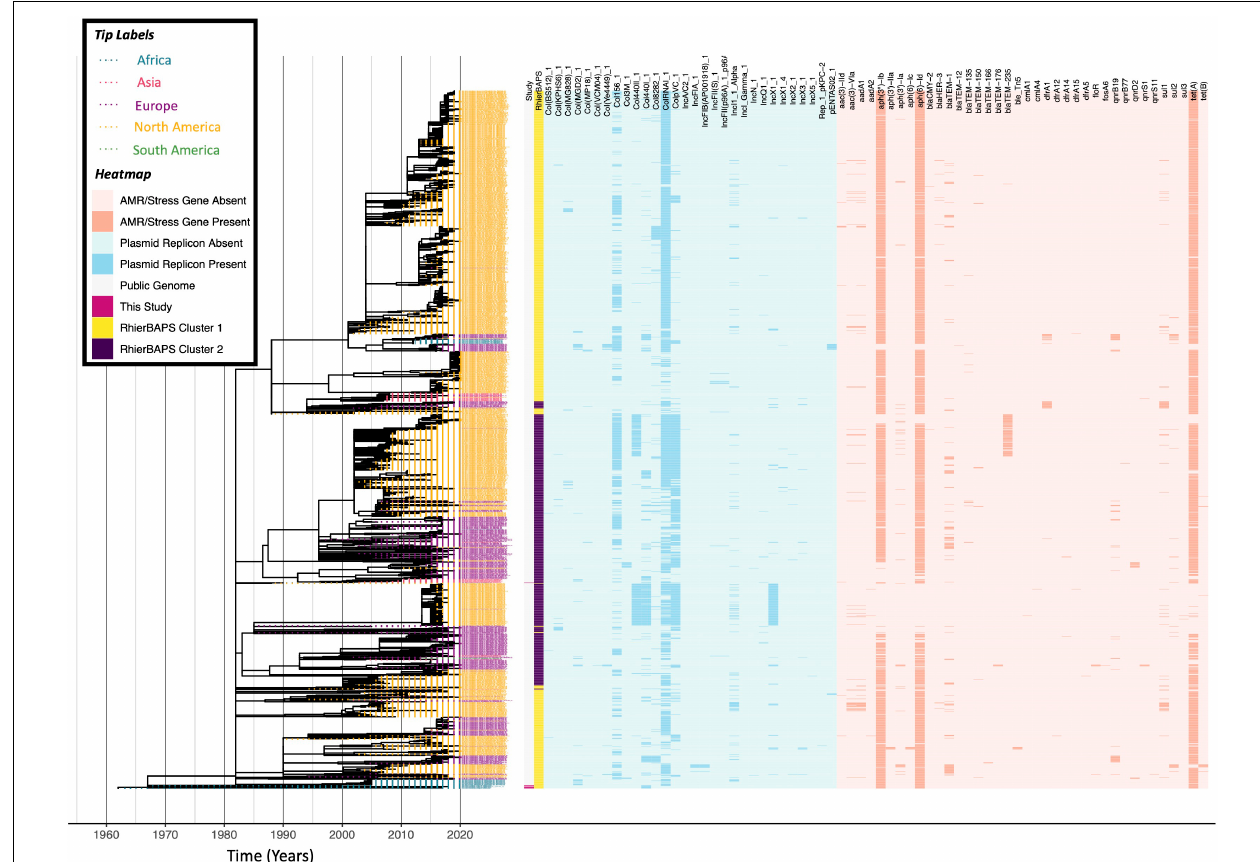
FIGURE 5 | Maximum likelihood phylogeny constructed using core SNPs identified among 1,569 S. Hadar genomes (1,561 publicly available genomes, plus eight sequenced here). Tip label colors denote the continent from which each strain was reported to have been isolated. The heatmap to the right of the phylogeny denotes: (i) whether an isolate was sequenced in conjunction with this study (dark pink) or not (gray; “Study”); (ii) level 1 cluster assignments obtained using RhierBAPS (“RhierBAPS”); the presence and absence of (iii) plasmid replicons (blue) and (iv) antimicrobial resistance (AMR) determinants (orange). The phylogeny was rooted and time scaled using LSD2, with branch lengths reported in years ( X -axis). Core SNPs were identified among all genomes using Parsnp. AMR determinants were identified using ABRicate, the NCBI AMR determinant database, and minimum identity and coverage thresholds of 75 and 50%,